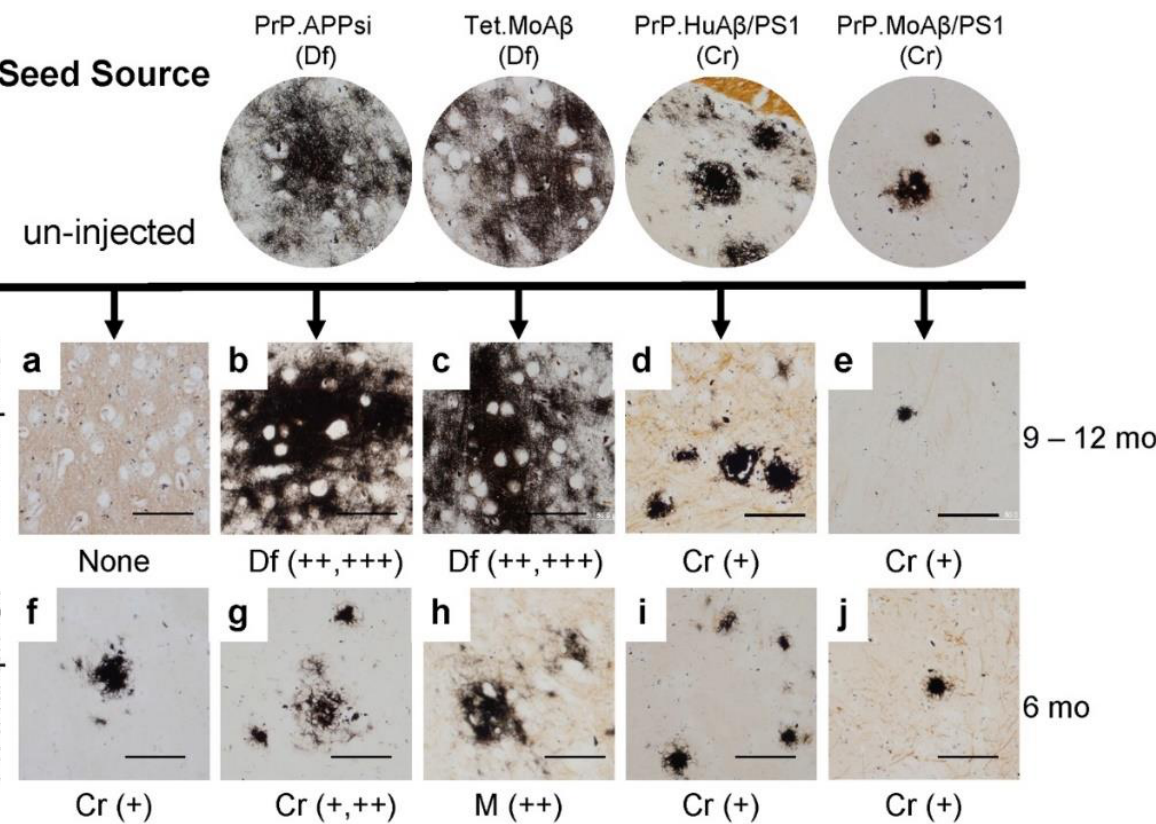
Figure 1. Competition between diffuse and cored strains of Aβ pathology in APP transgenic hosts. The upper panels show high- power images of Aβ deposit morphology, revealed by C -S silver stain- ing (see Methods), in the brains of mice that provided seed sources [26] and the recipients of these seeding injections. The lower panels show low-power views of the seeded animals. Details of animal numbers for each injection are summarized in Table 2, with details of individual animals provided in Table S1. PrP.MoAβ/PS1 mice were aged 9 – 12 months before harvest ( a – e , bʹ – eʹ , bʹʹ – eʹʹ ), and PrP.HuAβ/PS1 mice were aged 6 months post-injection ( f – j , gʹ – jʹ , gʹʹ – jʹʹ ). In the upper panel, below each row of images from the seeded animals, we provide information on pathological rating (Df = diffuse; Cr = cored) and relative severity. Blinded observers reviewed the images and scored the burden of Aβ pathology based on the following criteria: “+++” = heavy Aβ burden distributed throughout the cortex and hippocampus (examples are panels ( b ʹ , cʹ , bʹʹ , cʹʹ ) ). “++” = obvious pathol- ogy with patchy deposition in cortex and hippocampus (examples are panels ( hʹ , h ʹʹ ) ). “+” = con- sistent but minimal pathology ( dʹ , eʹ , gʹ , iʹ , jʹ ). ( a – j ) Images of amyloid deposits in cortex, imaged by microscope with 40× objective lens, scale bar =50µm. ( bʹ – jʹ ) Images of hippocampus cropped from 20× Aperio system scanned images, 5000 × 3750 pixels, scale bar =500µm. ( bʹʹ – jʹʹ ) Images of cortex cropped from 20× Aperio system scanned images, 2000 × 1500 pixels, scale bar = 200 µm. Each animal